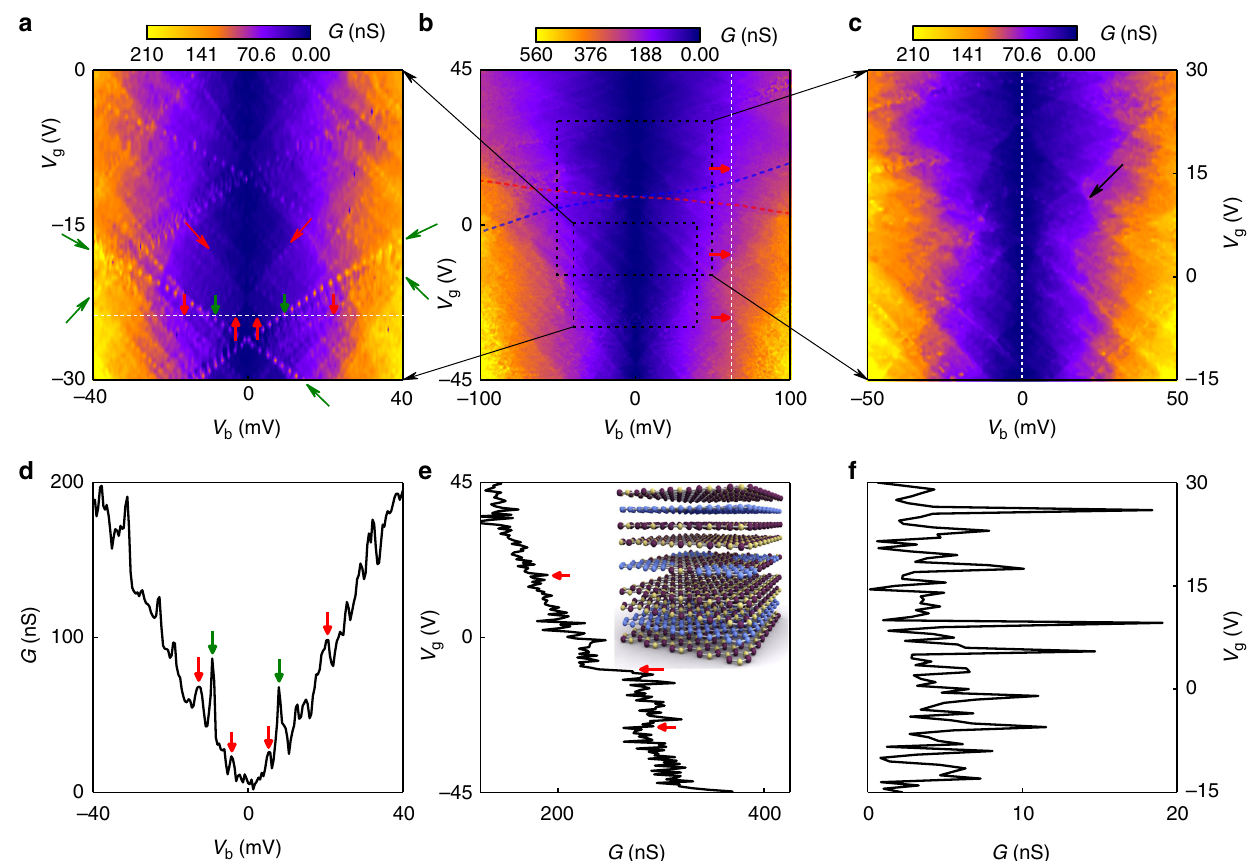
Fig. 4 Multi-channel single-electron tunnelling transistors based on the GQDs of 13 nm in size. a The low excitation measurements of low bias region of b . Thin and long green arrows indicate the tunnelling events through the localised states in the middle hBN layer. Thick and short arrows indicate the edges of the Coulomb diamonds (red), and the resonances from localised impurity states (green) crossing the white dashed line ( G ( V g = − 24V, V b ), presented on d ). b Conductance G ( V g , V b ) measured at T = 250mK. The red (blue) dashed line mark the event of the Fermi level in the top (bottom) graphene layer aligning with the Dirac point. Red arrows indicate the edges of the Coulomb diamonds crossing the white dashed line ( G ( V g , V b = 63 mV), presented on e ). c The magni fi ed plot of b denoting the peculiar shape of Coulomb diamonds when the Fermi level in one of the graphene contacts aligns with the Dirac point (black arrow). The dashed white line indicates the cross-section presented in f . d The plot of conductance G ( V g = − 24V, V b ) from a . Thick and short arrows indicate the same events as in a : the edges of the Coulomb diamonds (red), and the resonances from localised impurity states (green). e The conductance G ( V g , V b = 63 mV) plot. Red arrows indicate the same events as in b : edges of the Coulomb diamonds. The inset shows the schematic structure of the van der Waals stack. Graphene contacts are separated by hexagonal boron nitride layers from the GQD-hBN layer. Carbon atoms are blue, boron — yellow, nitrogen — purple. f The conductance G ( V g , V b = 0 mV) plot from c (marked by white dashed